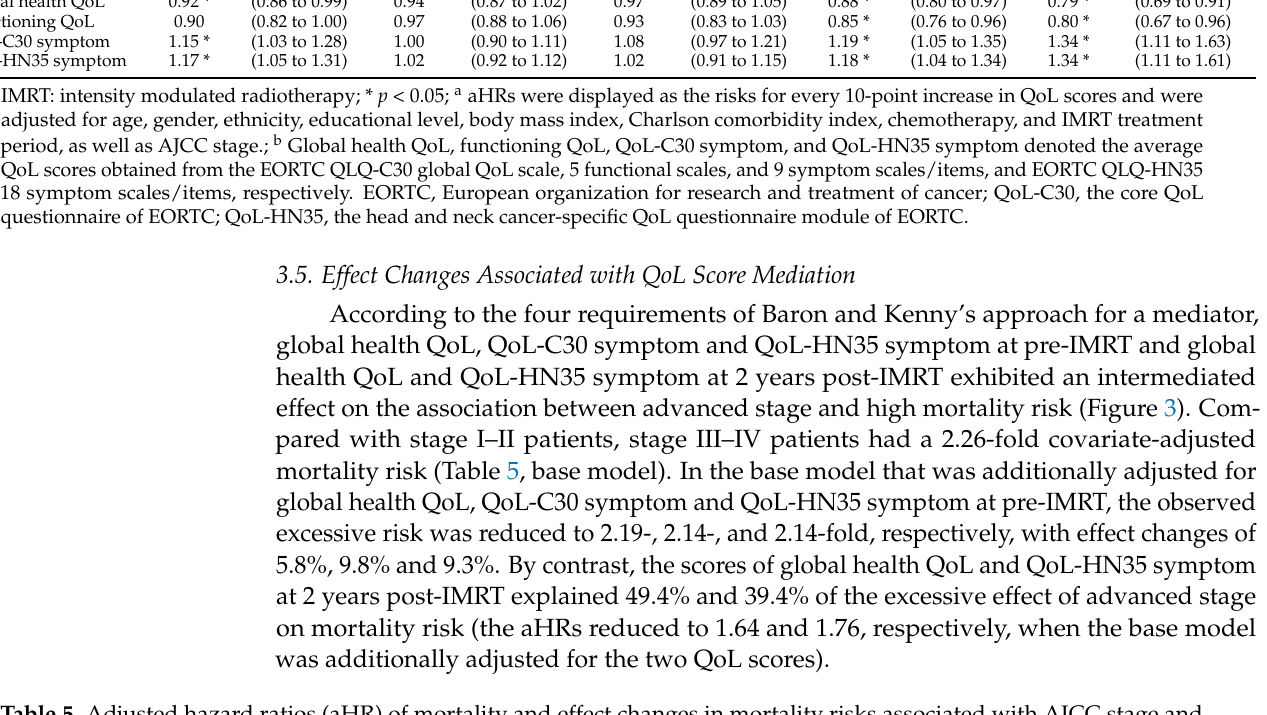
Table 5. Adjusted hazard ratios (aHR) of mortality and effect changes in mortality risks associated with AJCC stage and quality of life (QoL) scores at different time points of